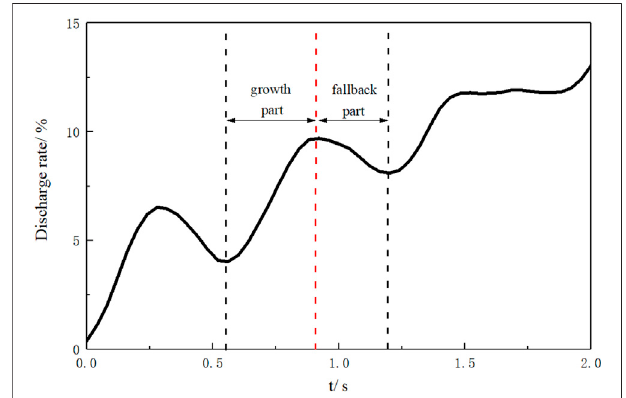
FIGURE 6 | Fluctuation regions with periodic “ fallback ” in the initial discharge